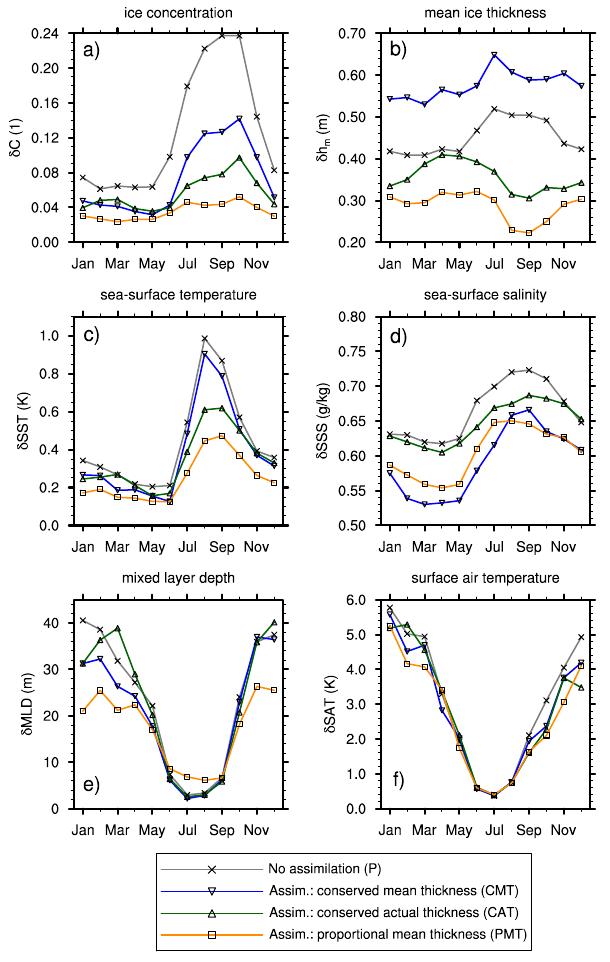
Fig. 2. Average point-wise root mean square error for each month over the Arctic Ocean for (a) sea-ice concentration, (b) sea-ice mean thickness (c) sea-surface temperature, (d) sea-surface salin- ity, (e) ocean mixed layer depth, and (f) surface air temperature. All errors are obtained from the differences to the reference run of the identical-twin